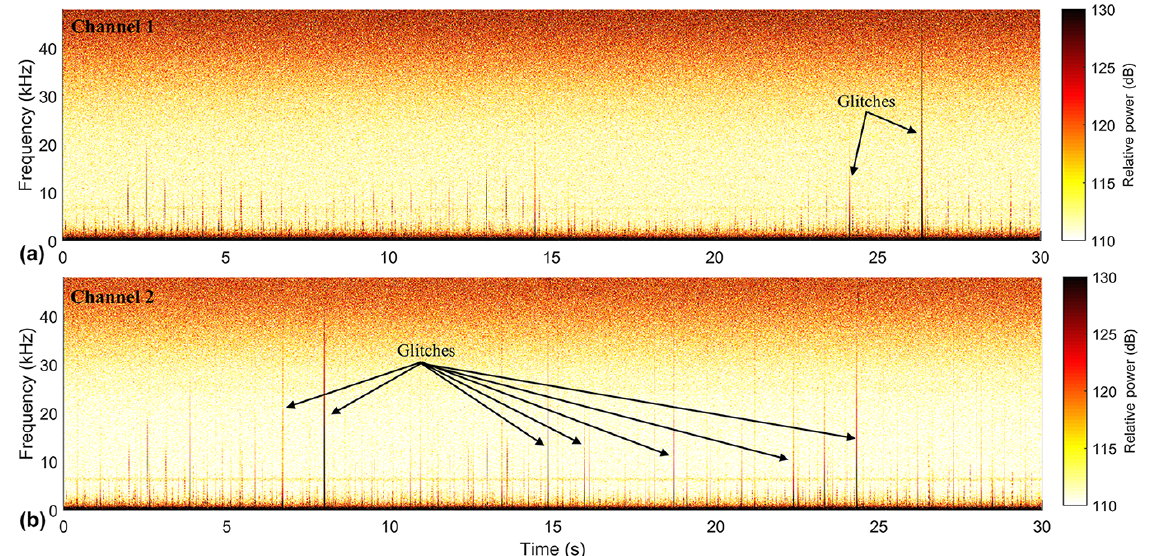
Figure 7. Spectrogram of 30s of data recorded on channel 1 (a) and channel 2 (b) showing the occurrence of glitches for the same period. While there were only two instances when glitches occurred on channel 1, they showed up many times on channel 2 (only a few are actually shown).